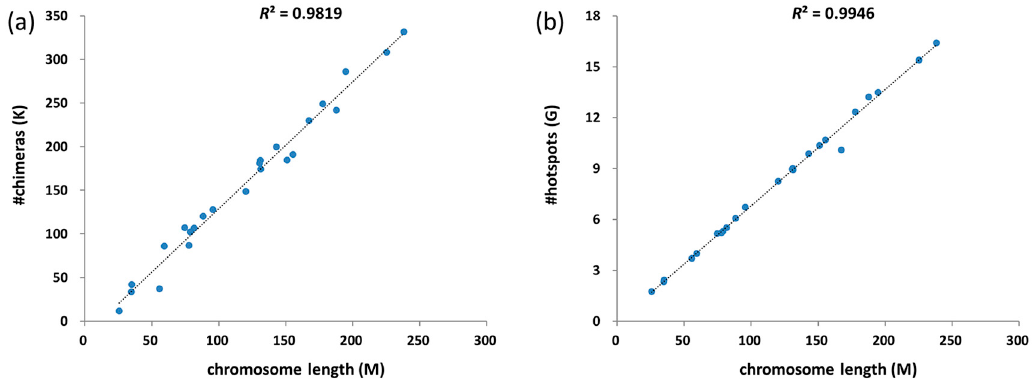
Figure 2. Scattergraph of number of chimeras or hotspots and chromosome lengths. ( a ) Scattergraph of number of chimeras and chromosome lengths. The number of chimeras in chromosome X and Y are doubled in the illustration because the other chromosomes are diploid; ( b ) Scattergraph of number of chimeric hotspots and chromosome lengths.